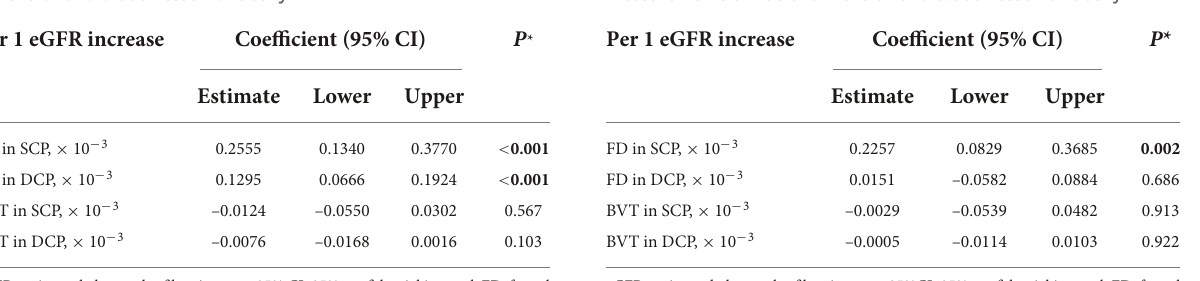
TABLE 3 Univariable linear regression of renal function with fractal dimension and blood vessel tortuosity.